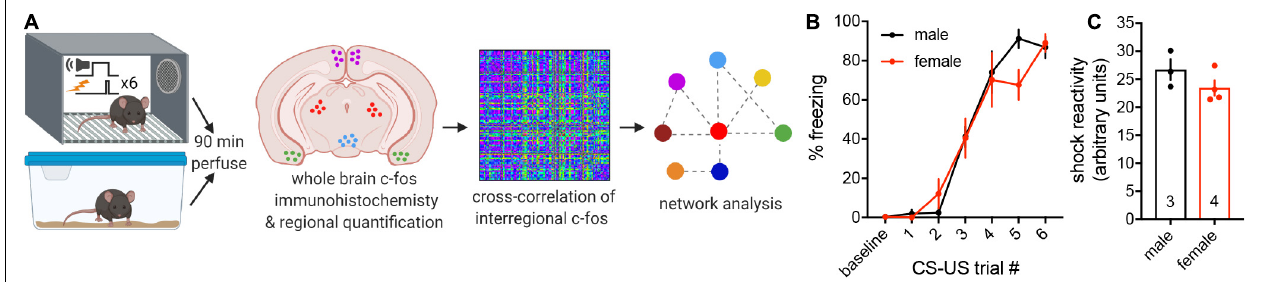
FIGURE 1 | Experimental pipeline and behavioral quantification. (A) Adult male and female mice were randomly assigned to cued threat conditioning or naïve homecage conditions. Mice were perfused 90 min later, and brain-wide neuronal activation was assessed through immunofluorescence staining and quantification of the immediate early gene c-fos. Interregional correlations of c-fos expression were computed across 112 brain regions to determine functional connectivity. Supra-threshold correlations were then used to generate functional networks and identify hub regions for threat conditioning using graph theoretical approaches. Schema made with Biorender.com. (B) No differences in freezing during the CS were observed between trained males and females across CS-US pairings during threat conditioning. (C) No differences in average shock reactivity were observed between males and females during threat conditioning. Data presented as mean ± SEM. (B) Two-way repeated-measures ANOVA. (C) Two-tailed t -test. n/group denoted on bar histogram in panel (C)